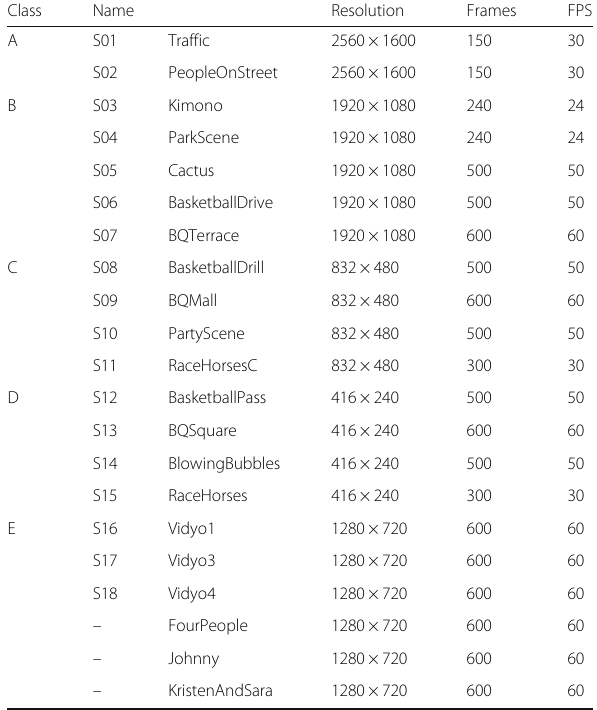
Table 3 The information of the testing